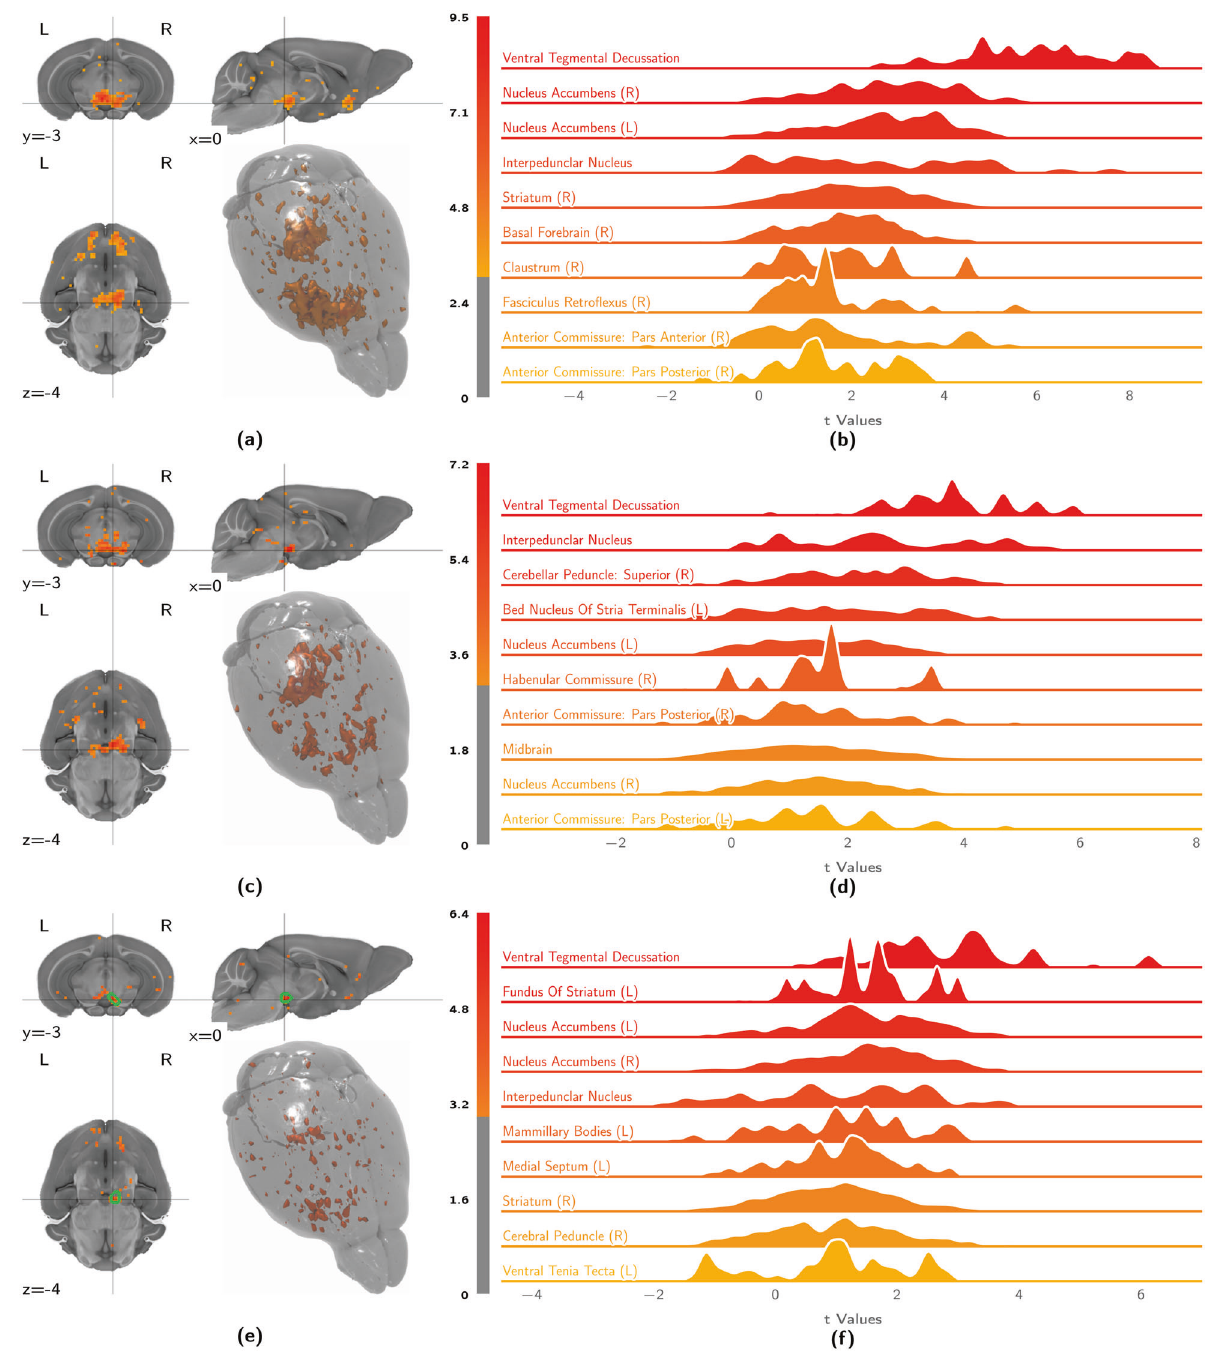
Fig. 3 Block stimulation elicits strong ventral striatal activity in the best implant group, more rostrally weighted activity in the rejected implant group, and generates similar but weaker contrasts for VTA seed-based analysis. The fi gures show volumetric population t-statistic maps ( a, e, c ) thresholded at t ≥ 3 and centered on the VTA target, as well as a break-down of activation along atlas parcellation regions ( b, d, f ). a Second-level t-statistic map for block-stimulus-evoked activity in best implant group animals (corrected for the wild- type control response). b Distribution densities of statistic values from block-stimulus-evoked activity analysis in best implant group animals (corrected for the wild-type control response). Depicted are the 10 most strongly activated areas. c Second-level t-statistic map for block-stimulus-evoked activity in rejected implant group animals (corrected for the wild-type control response). d Distribution densities of statistic values from block-stimulus-evoked activity analysis in rejected implant group animals (corrected for the wild-type control response). Depicted are the 10 most strongly activated areas. e Second-level t-statistic map for VTA seed-based functional connectivity during block stimulation in best implant group animals (VTA region in green). f Distribution densities of statistic values from seed-based functional connectivity analysis of best implant group animal block stimulation scans. Depicted are the 10 most strongly activated